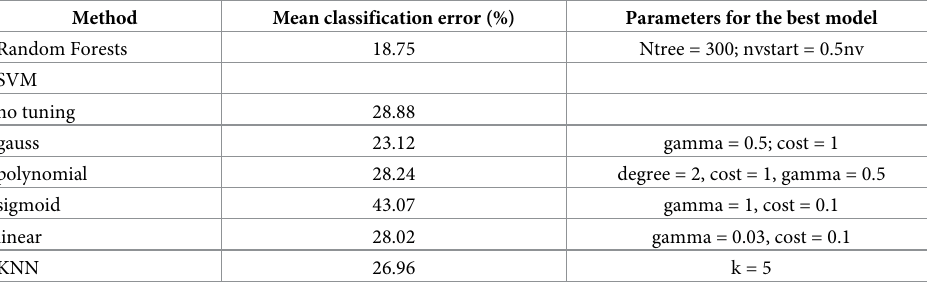
Table 3. Results of variable classifications vs. algorithms used.